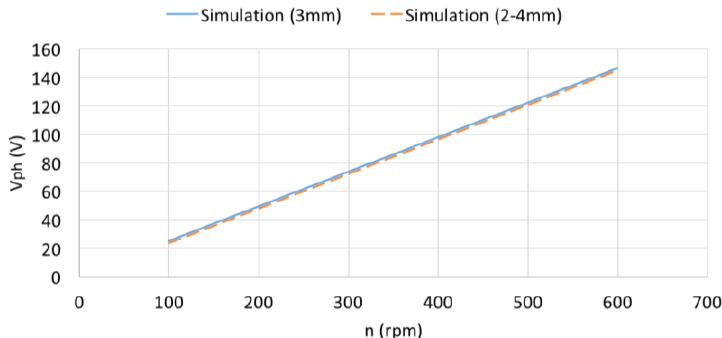
Figure 16. Plot versus the speed of the output phase voltage at no-load (Back-EMF) in simulation model with 3 mm air gaps compared to that of the simulation model with 2–4 mm air gaps.